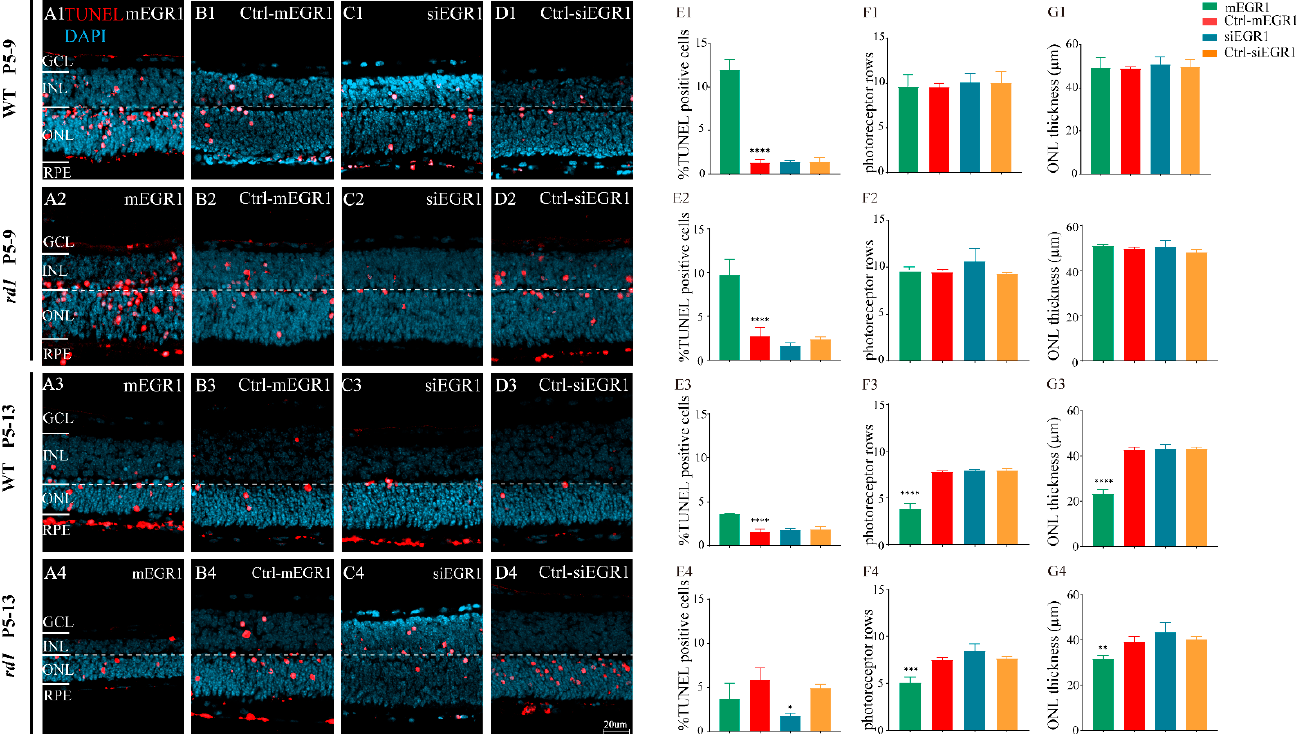
Figure 4. EGR1 expression promotes photoreceptor cell death in WT and rd1 retinas. WT and rd1 in vitro retinal explants cultured from P5 onwards were treated with different genetic constructs to either silence or overexpress EGR1. The TUNEL assay (red) was used to examine photoreceptor death at P9 and P13. DAPI (blue) was used as a nuclear counterstain. ( A1–A4 ) Cross-sectional images of retinas treated with EGR1 overexpression vector (adeno-associated viral (AAV) vector, 1.84 × 10 10 viral genomes (vg)/mL, 10 µL for each retinal explant). ( B1–B4 ) Retinas treated with EGR1 control vector (negative control, AAV vector without mEGR1). ( C1–C4 ) Retinas treated with siRNA construct for EGR1 knockdown (AAV9-Egr1-RNAi 1.57 × 10 9 vg/mL, 10 µL for each retinal explant). ( D1–D4 ) Retinas treated with control vector for EGR1 siRNA (negative control AAV vector, without siRNA EGR1). ( E1–E4,F1–F4,G1–G4 ) Quantification of ( E1–E4 ) TUNEL positive cells in the outer nuclear layer (ONL), ( F1–F4 ) photoreceptor row counts, and ( G1–G4 ) thickness of the ONL in µm. Images shown are representative of observations for at least six different specimens of each genotype. Error bars represent SD. ONL = outer nuclear layer, INL = inner nuclear layer, GCL = ganglion cell layer. Scale bar = 20 µm. * = p < 0.05; ** = p < 0.01; *** = p < 0.001; and **** = p < 0.0001.